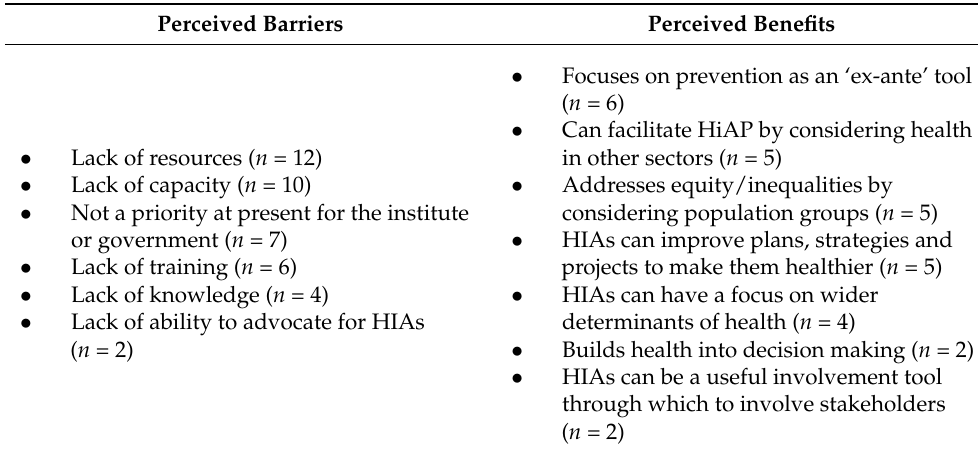
Table 1. Survey responses—barriers and benefits of